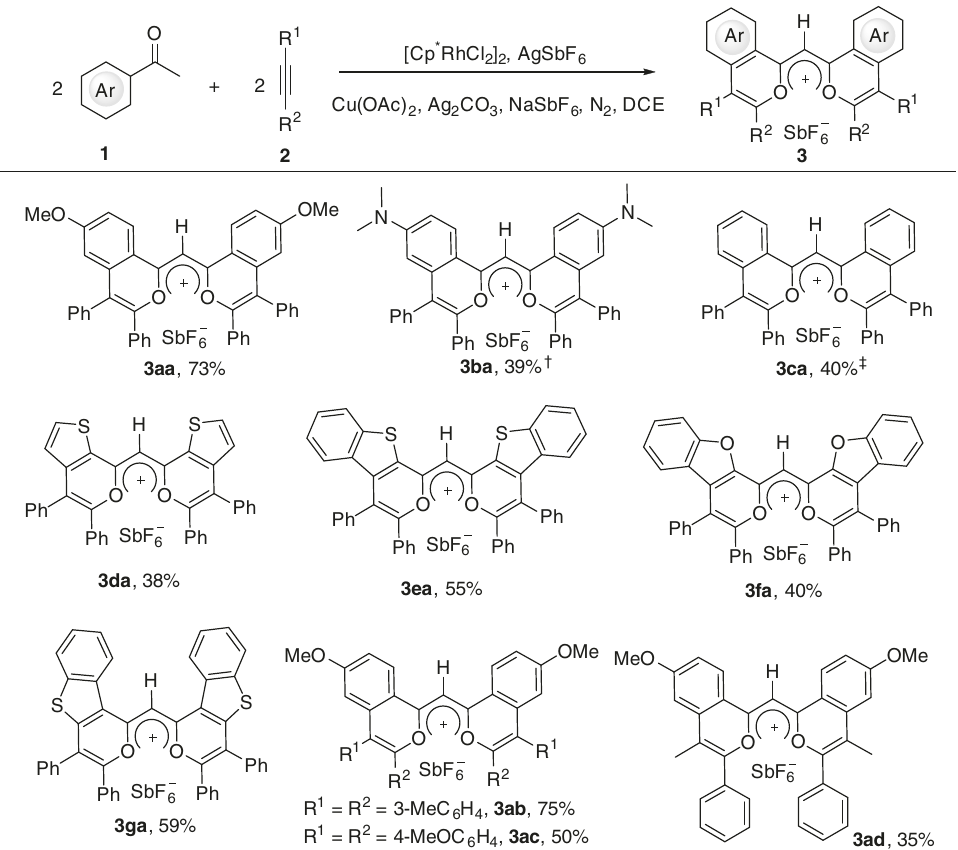
Fig. 4 Substrate scope. Reaction conditions: 1 (0.2 mmol), 2 (0.3 mmol), [Cp*RhCl 2 ] 2 (5 mol%), AgSbF 6 (20 mol%), Ag 2 CO 3 (0.3 mmol), Cu(OAc) 2 ·H 2